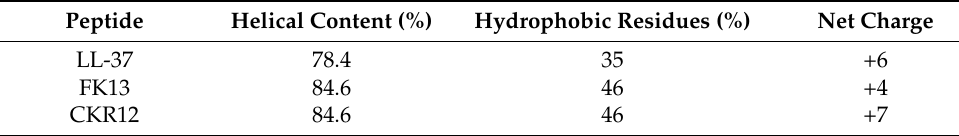
Table 1. Expected structural parameters of LL-37, FK13, and CKR12.